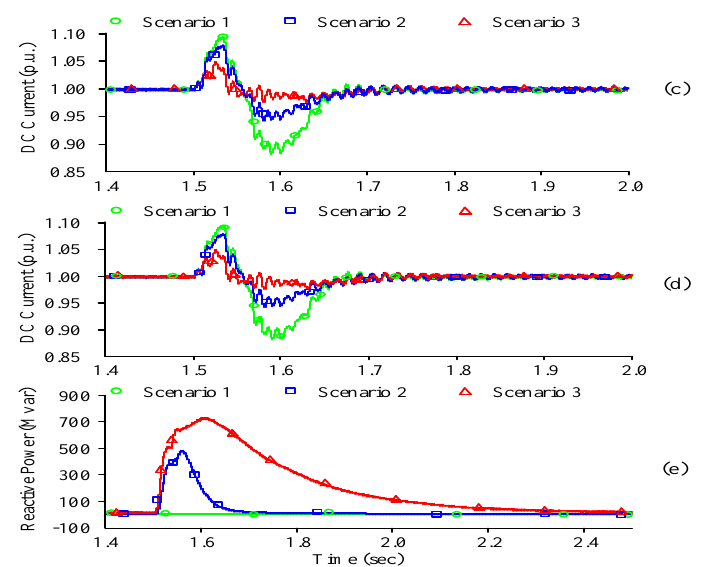
Figure 7. Simulation results for single phase fault. ( a ) Extinction angle of the HEC ( b ) Extinction angle of the LEC ( c ) DC current of the HEC ( d ) DC current of the LEC ( e ) Reactive power of the STATCOM.